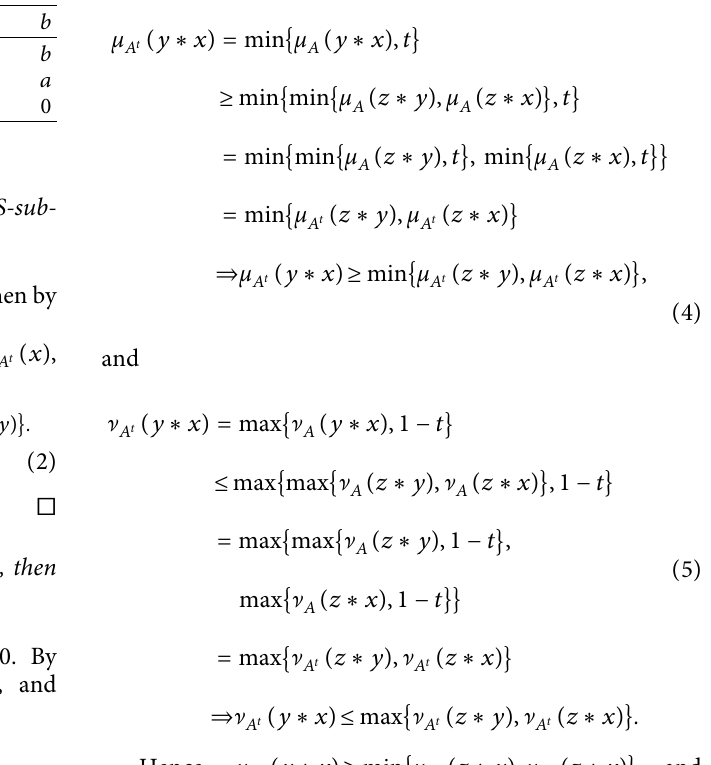
Table 1: ( X, ∗ , 0 ) is a